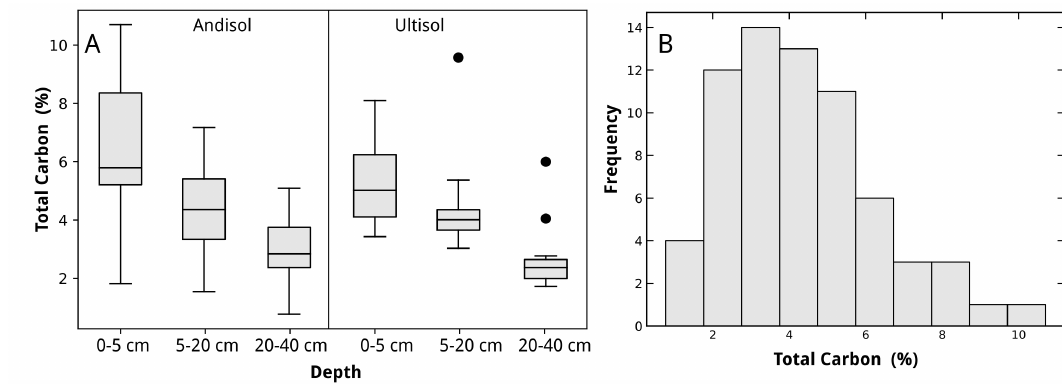
Figure 2. Carbon content by depth and soil order. ( A ) The full range variation is represented in the box and whisker diagrams. The top of the gray box is the third quartile and the bottom the first quartile. The horizontal line inside the box is the median of the data. Whiskers above and below the box show the minimum and maximum values and outliers are represented by black circles; ( B ) The distribution of the soil total carbon of the whole data set.